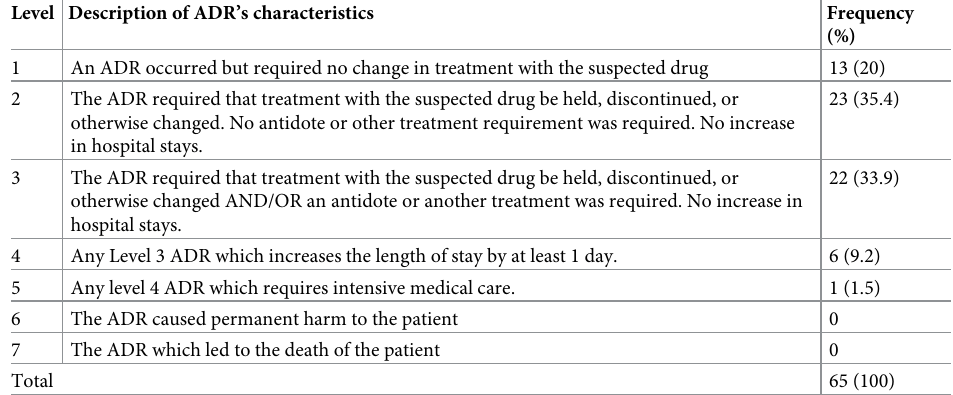
Table 6. Severity of ADRs among hospitalized patients in the UoGCSH medical ward from May 28 to July 26, 2022 (N =